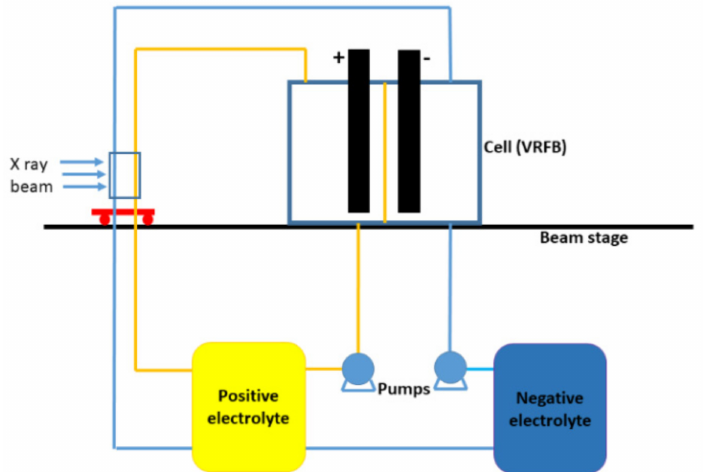
Figure 20. Schematic diagram of in situ synchrotron XANES experiment on VRFB to collect the transmission spectra (adapted with permission from ref [163] American Chemical